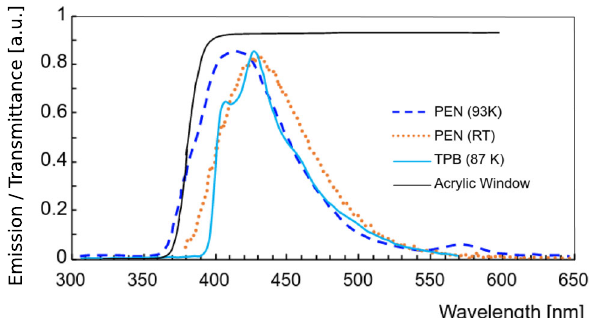
Fig. 14 Schematic of the light produced by the source in the bottom and detected by the PMT at the top in the VUV-only measurement of the absorber (left) and the VUV+vis measurement of a WLSR sample (right). For the WLSR, part of the VUV light is absorbed, re-emitted in blue and scattered until it reaches the PMT index of ∼ 1.5 (value from [54]), and negligible